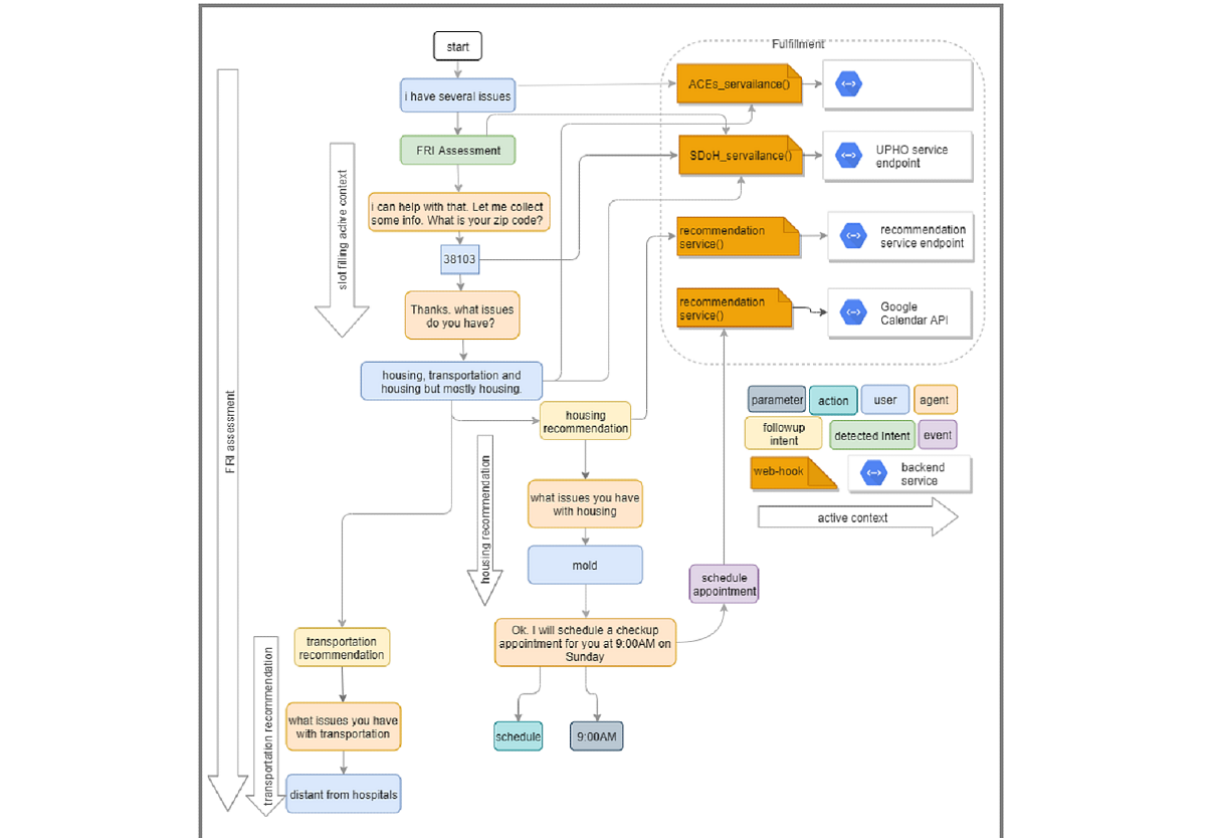
Figure 4. Sample conversation flow to demonstrate the different constructs used to define the question-answering (QA) agent, including intents, contexts, events, fulfillments, and webhooks. ACEs: adverse childhood experiences; UPHO: Urban Population Health Observatory; FRI: Family Resilience Initiative; SDoH: social determinants of